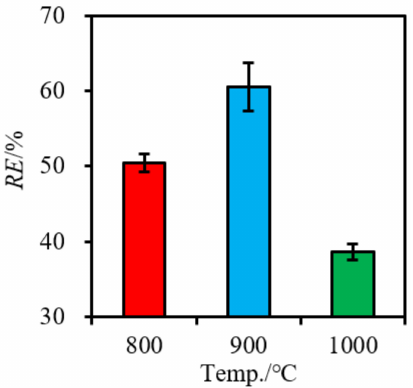
Figure 3. Phosphorous fixed in the ash of SS during combustion at 800–1000 ◦ C.